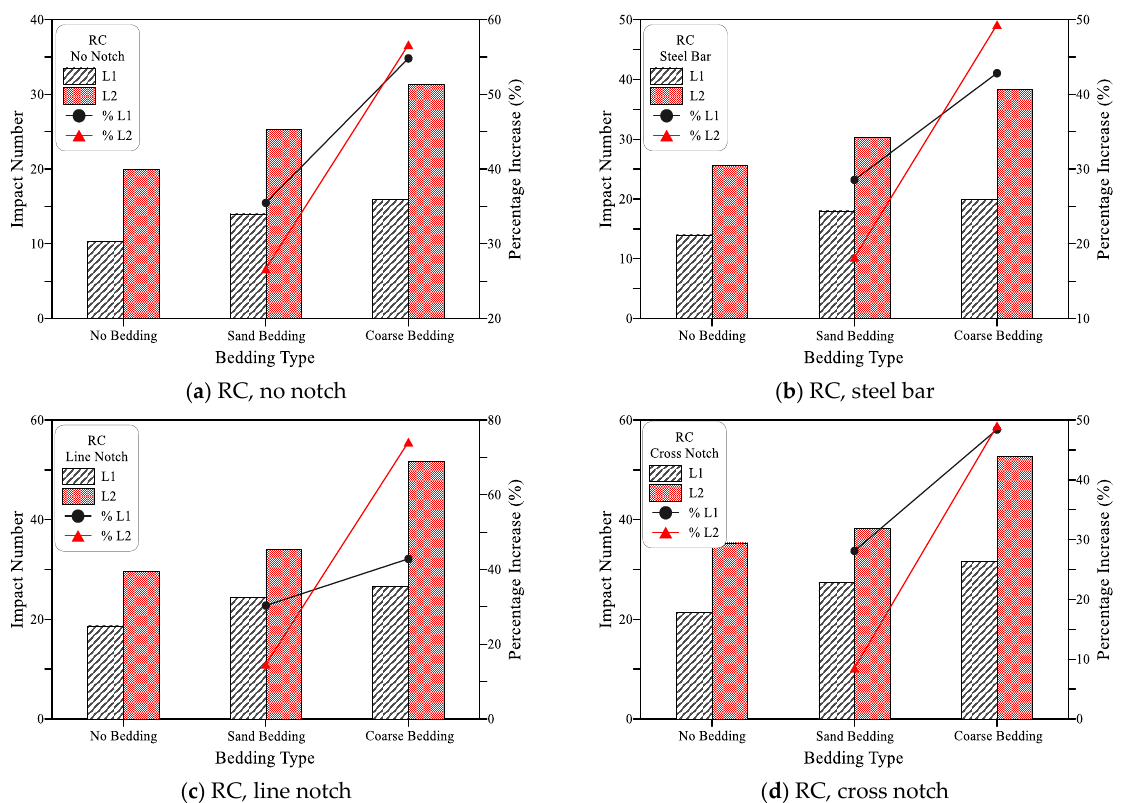
Figure 16. Bedding type effect on cracking and failure impact numbers of RC specimens ( a ) RC, no notch, ( b ) RC, steel bar, ( c ) RC, line notch ( d ) RC, cross notch.